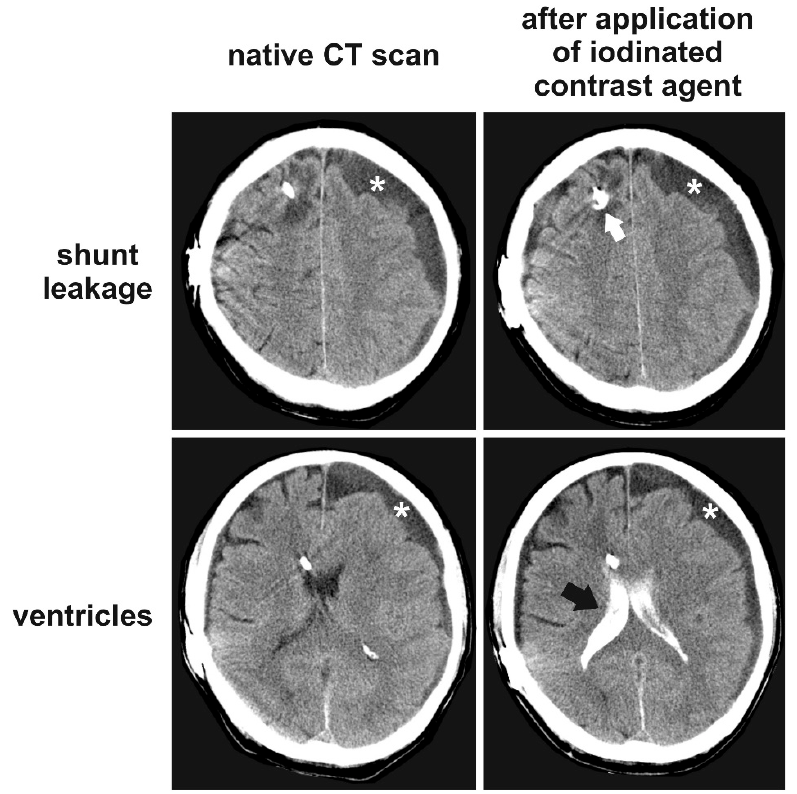
Figure 2. Shunt leakage in patient 6. This patient developed severe headaches immediately after the first intraventricular injection of thiotepa. The ventricles were promptly filled with the iodinated contrast enhancer after injection through the shunt catheter (black arrow). However, we detected a shunt leakage shortly after the entry point of the shunt catheter in the brain (white arrow). The hypodense area over the left hemisphere (white asterisks) is a pre-existing chronic subdural